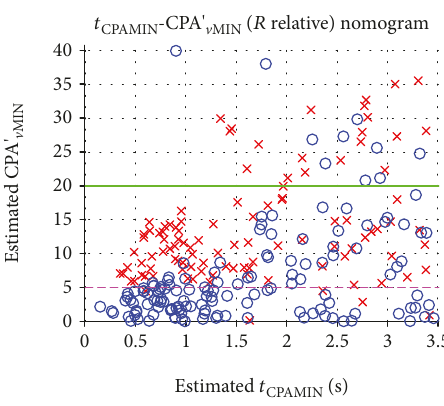
Figure 16: TTCPA-vertical CPA ( R relative) nomogram (red x: vertical far encounters; blue circle: vertical close